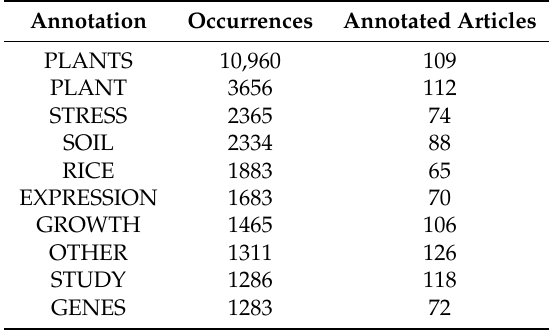
Table 1. The ten most common annotations in the whole data set, their number of occurrences and the number of articles annotated with them, sorted by the number of occurrences.